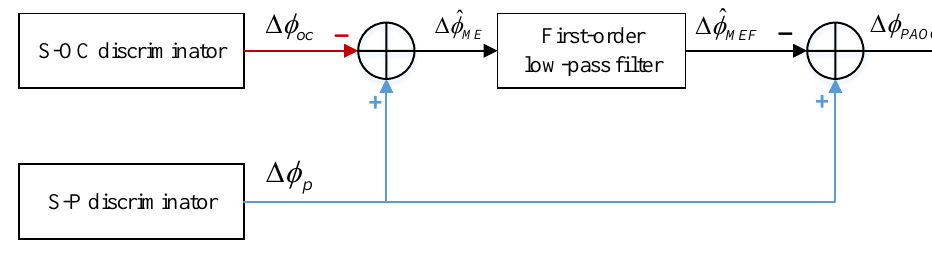
Figure 4. Schematic diagram of the PAOC technique for subcarrier multipath